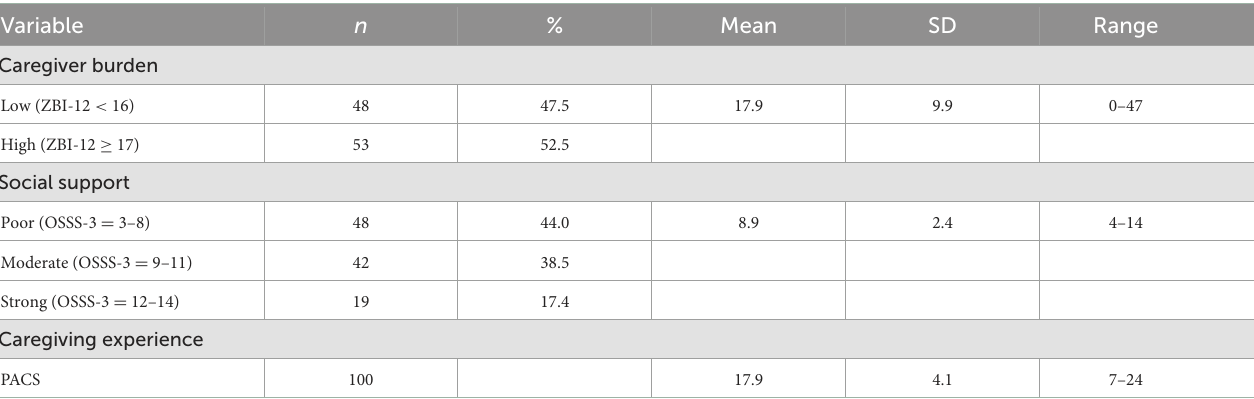
TABLE 2 Mean scores for the assessment